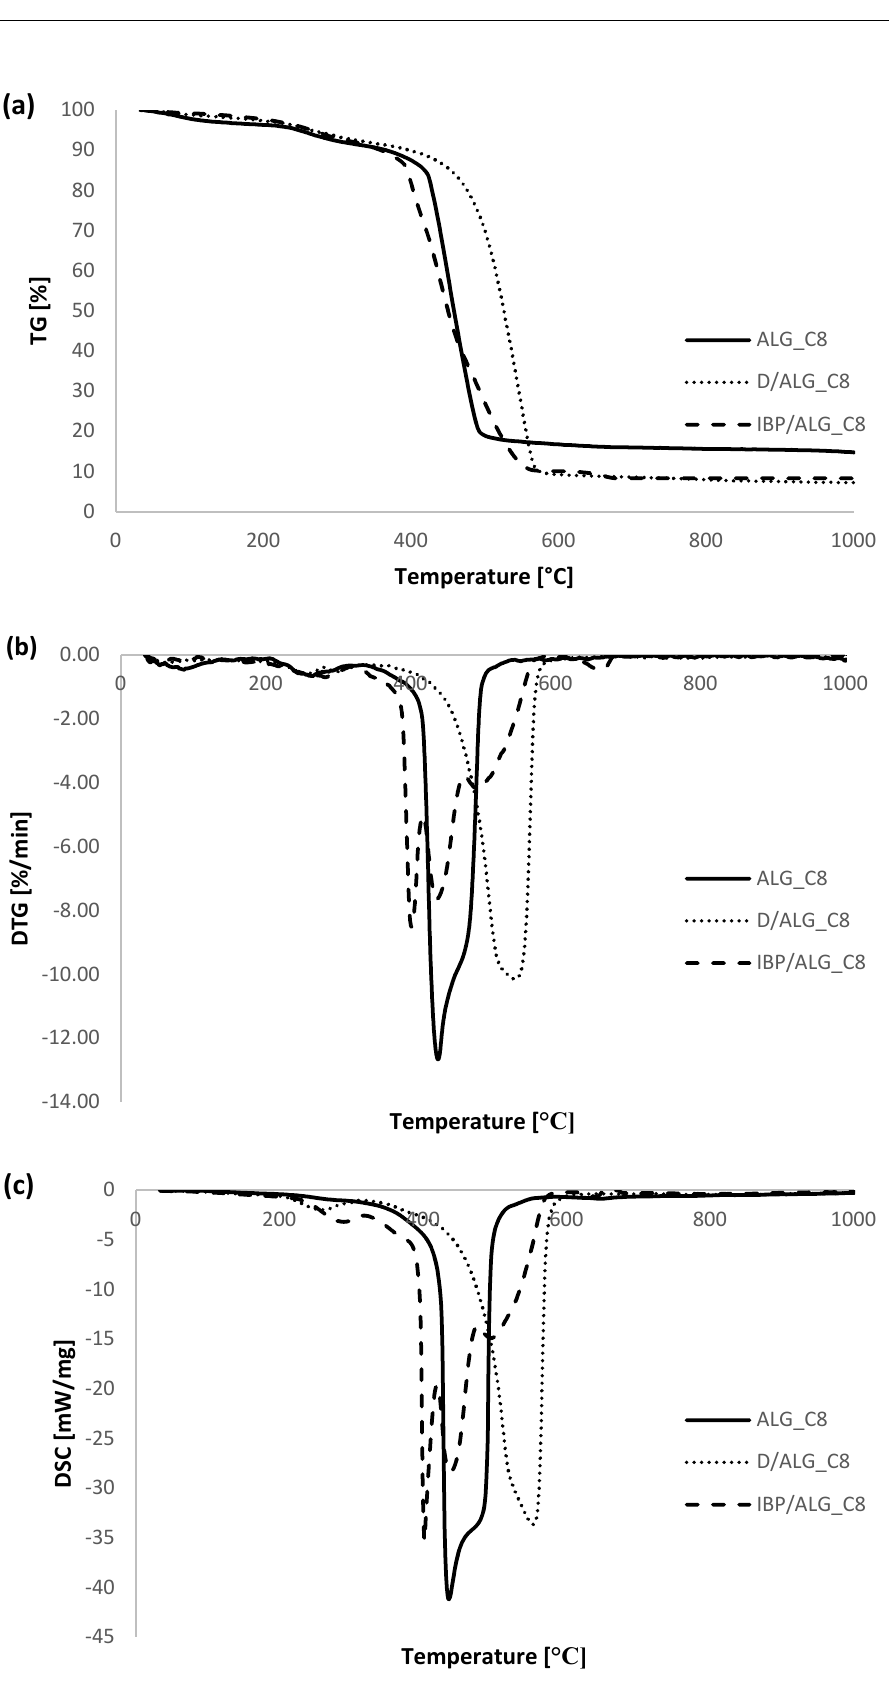
Figure 10. Comparison of TG ( a ), DTG ( b ), and DSC ( c ) curves ALG_C8 before and after diclofenac and ibuprofen adsorption.